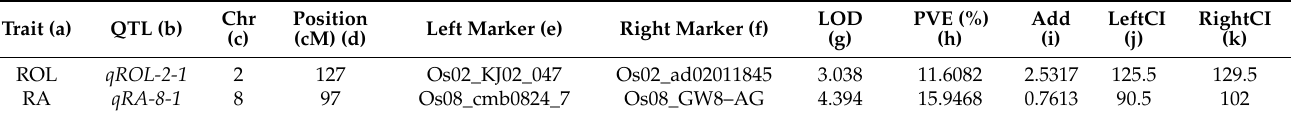
Table 1. Detected QTLs associated with radial oxygen loss and root area of